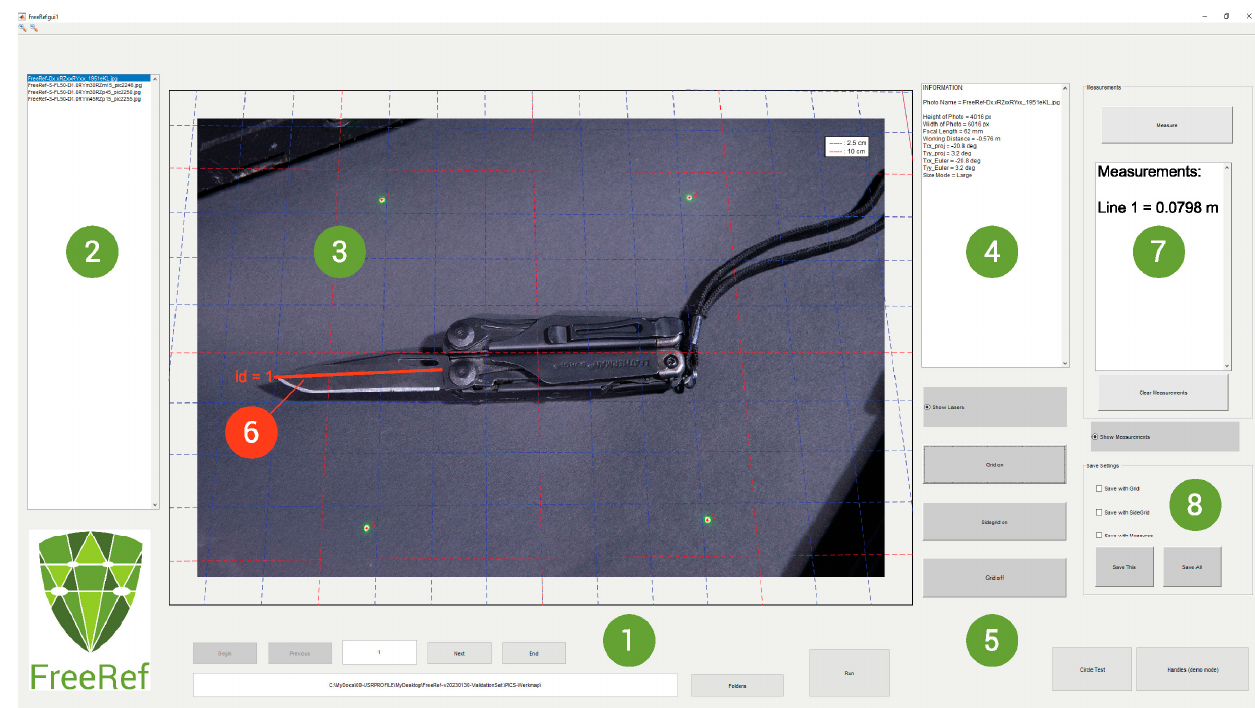
Figure 3. The FreeRef-1 (version 20230130) software interface. (1) Folder and file selection, and analysis run button. (2) List with photos found and analyzed in selected folder. (3) Viewing and working area showing the photo selected in area 2. The locations of the detected laser dots are marked with stars and a size reference grid is placed as an overlay, oriented with the same rotation as the calculated projection plane rotations. (4) Summary of photo info and detection results. (5) Buttons for hiding/displaying grid around or on the photo, and laser detection points on or off. (6) Measurement performed by the user in the shown photo. (7) Overview of measurement numbers and real-world lengths on the projection plane. (8) Picture-saving options selection buttons for exporting annotated files with grid or measurements added.